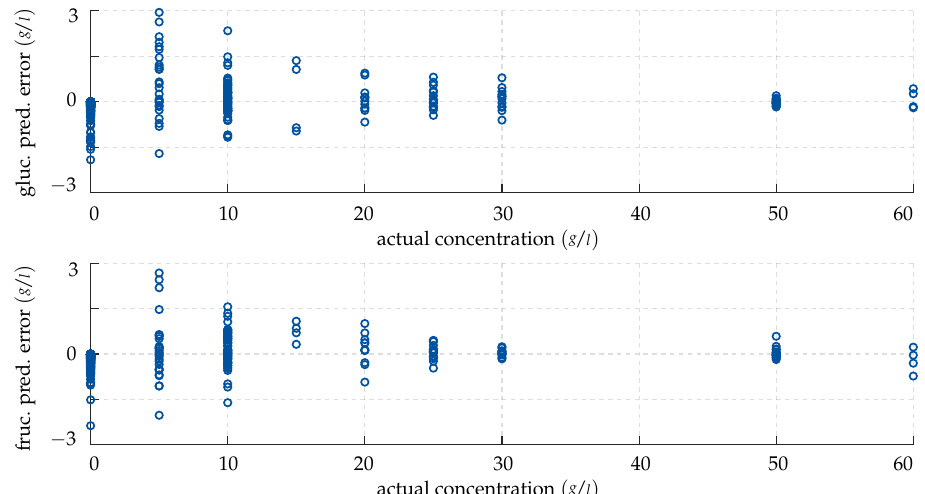
Figure 8. Prediction error made by the CFNN for the training data. ( Top panel ) deviation in the predicted glucose concentration plotted over the actual concentration. ( Bottom panel ) deviation in the predicted fructose concentration plotted over the actual concentration.